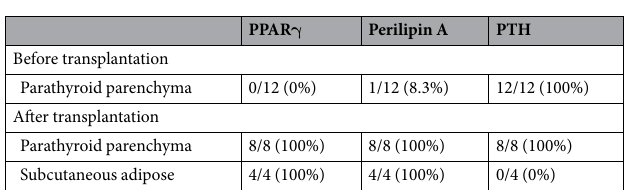
Figure 3. Parathyroid parenchymal tissues from secondary hyperparathyroidism patients transplanted into immunodeficient nude rats. Parathyroid parenchymal tissues from secondary hyperparathyroidism patients were transplanted between the thyroid and trachea of nude rats and recovered one to three-and-half months post-transplant. A representative specimen recovered one-month post-transplant is shown. (a) hematoxylin and eosin staining of human parathyroid transplants and recipient rat tissues. The empty arrow indicates human parathyroid transplants. A low-magnification view. Bar, 500 μ m. (b) an enlarged view of a part of ( a ) stained for PTH and visualized with green fluorescence. Bar, 200 μ m.